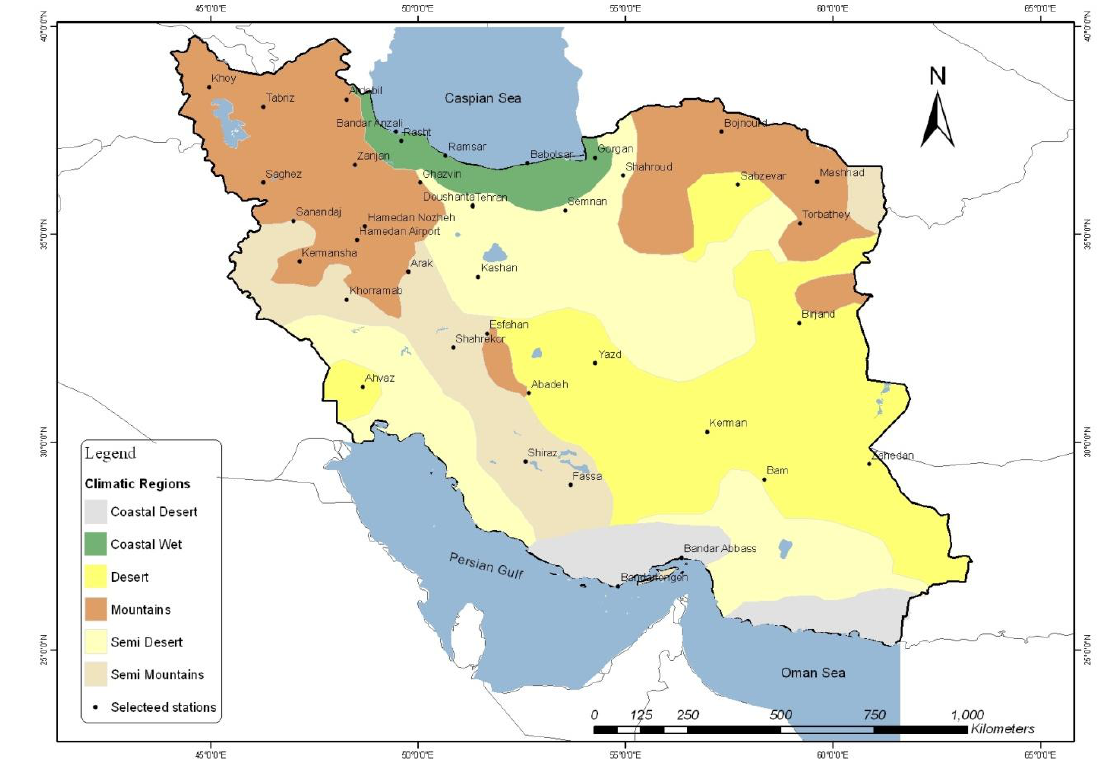
Figure 2. The study area classified into six climatic regions with spatial distribution of selected meteorological